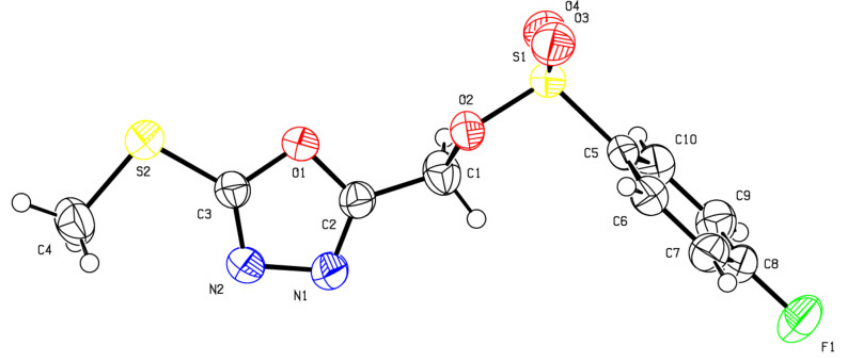
Figure 5. Crystal structure of compound 4a-2.